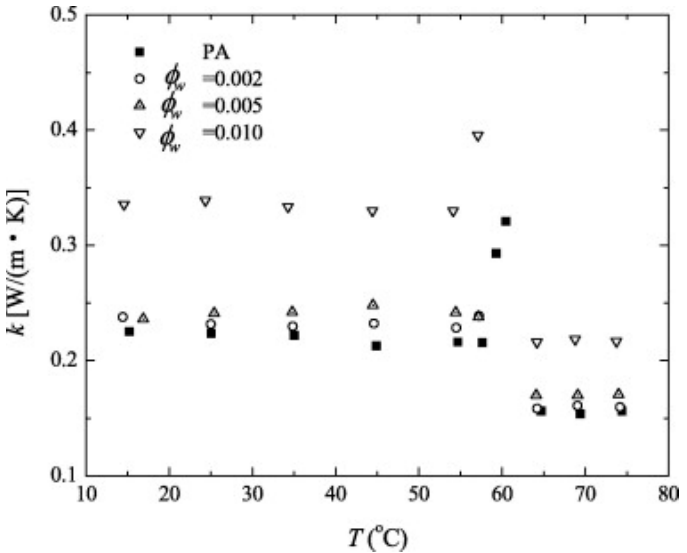
Figure 16. Temperature, thermal conductivity, and mass fraction reaction for palmitic acid/CNT NEPCM. (Reprinted with permission from ref. [23]. Copyright 2010 Solar Energy).